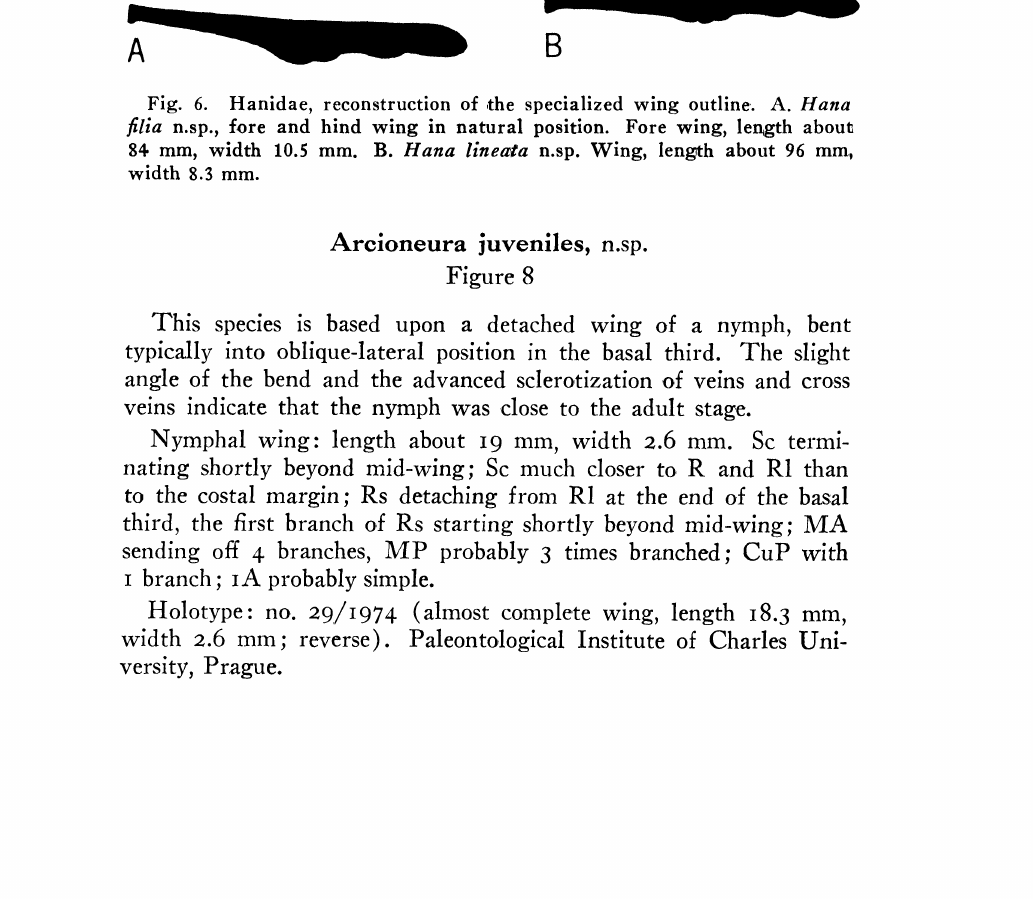
Fig. 6. Hanidae, reconstruction of ,the specialized wing outline,. A. Hana filia n.sp., fore and hind wing in natural position. Fore wing, length abou 84 ram, width 10.5 mm. B. Hana lineata n.sp. Wing, lenh about 96 ram, width 8.3 mm. Arcioneura juveniles,